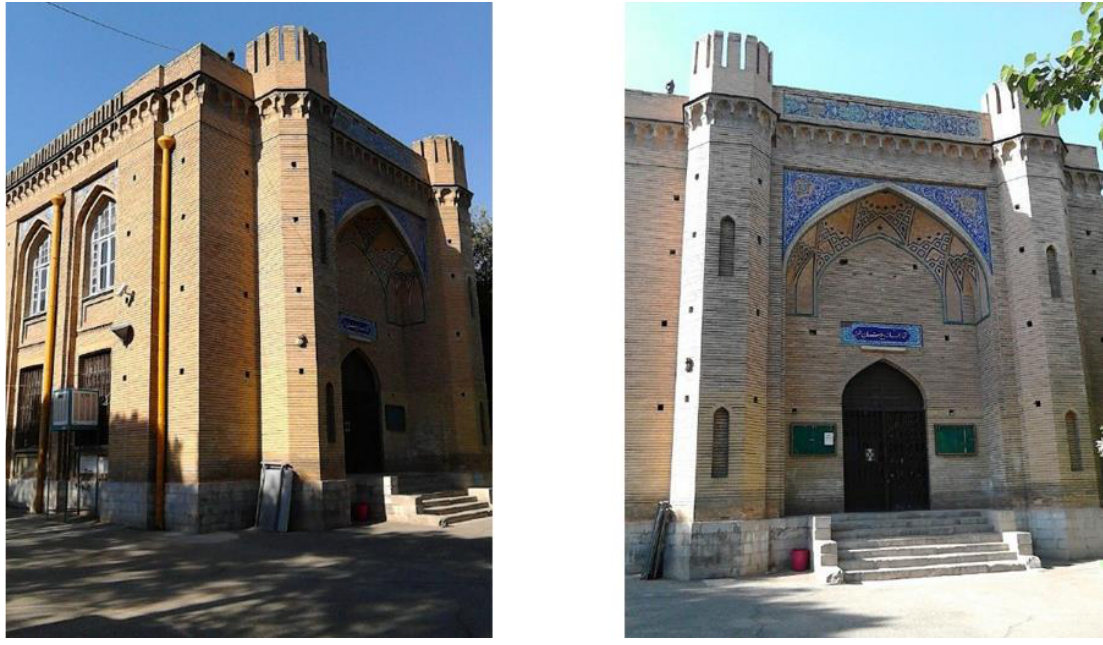
Figure 2 Using modern and tradition experiences Figure 3 Islamic and Safavid architecture and West beside each other modern architecture